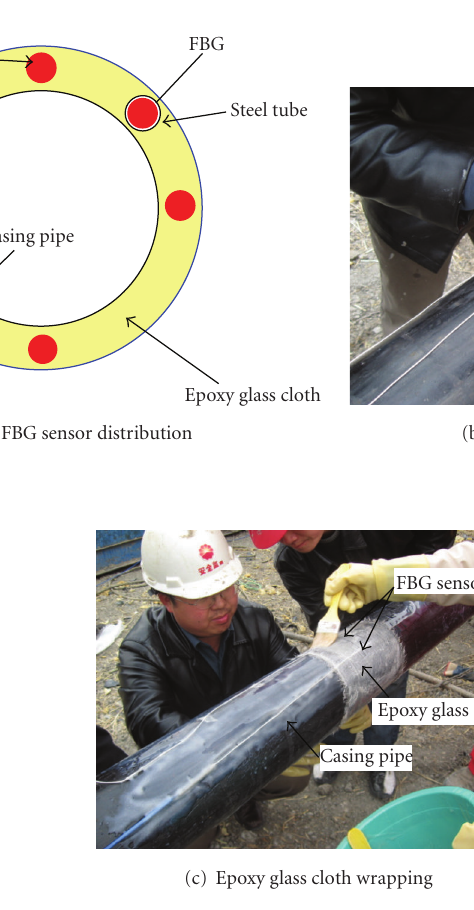
Figure 7: FBG sensor installation.